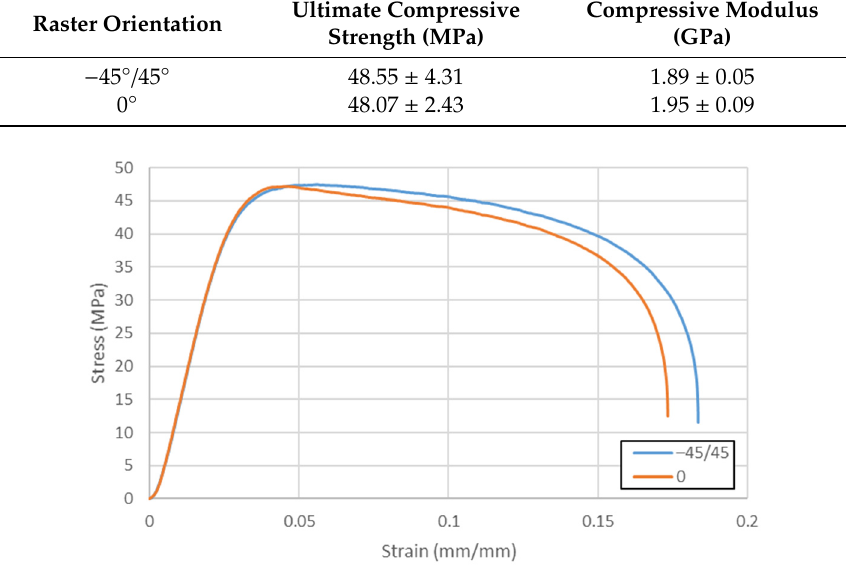
Figure 9. Representative Compressive Stress-Strain Curves.